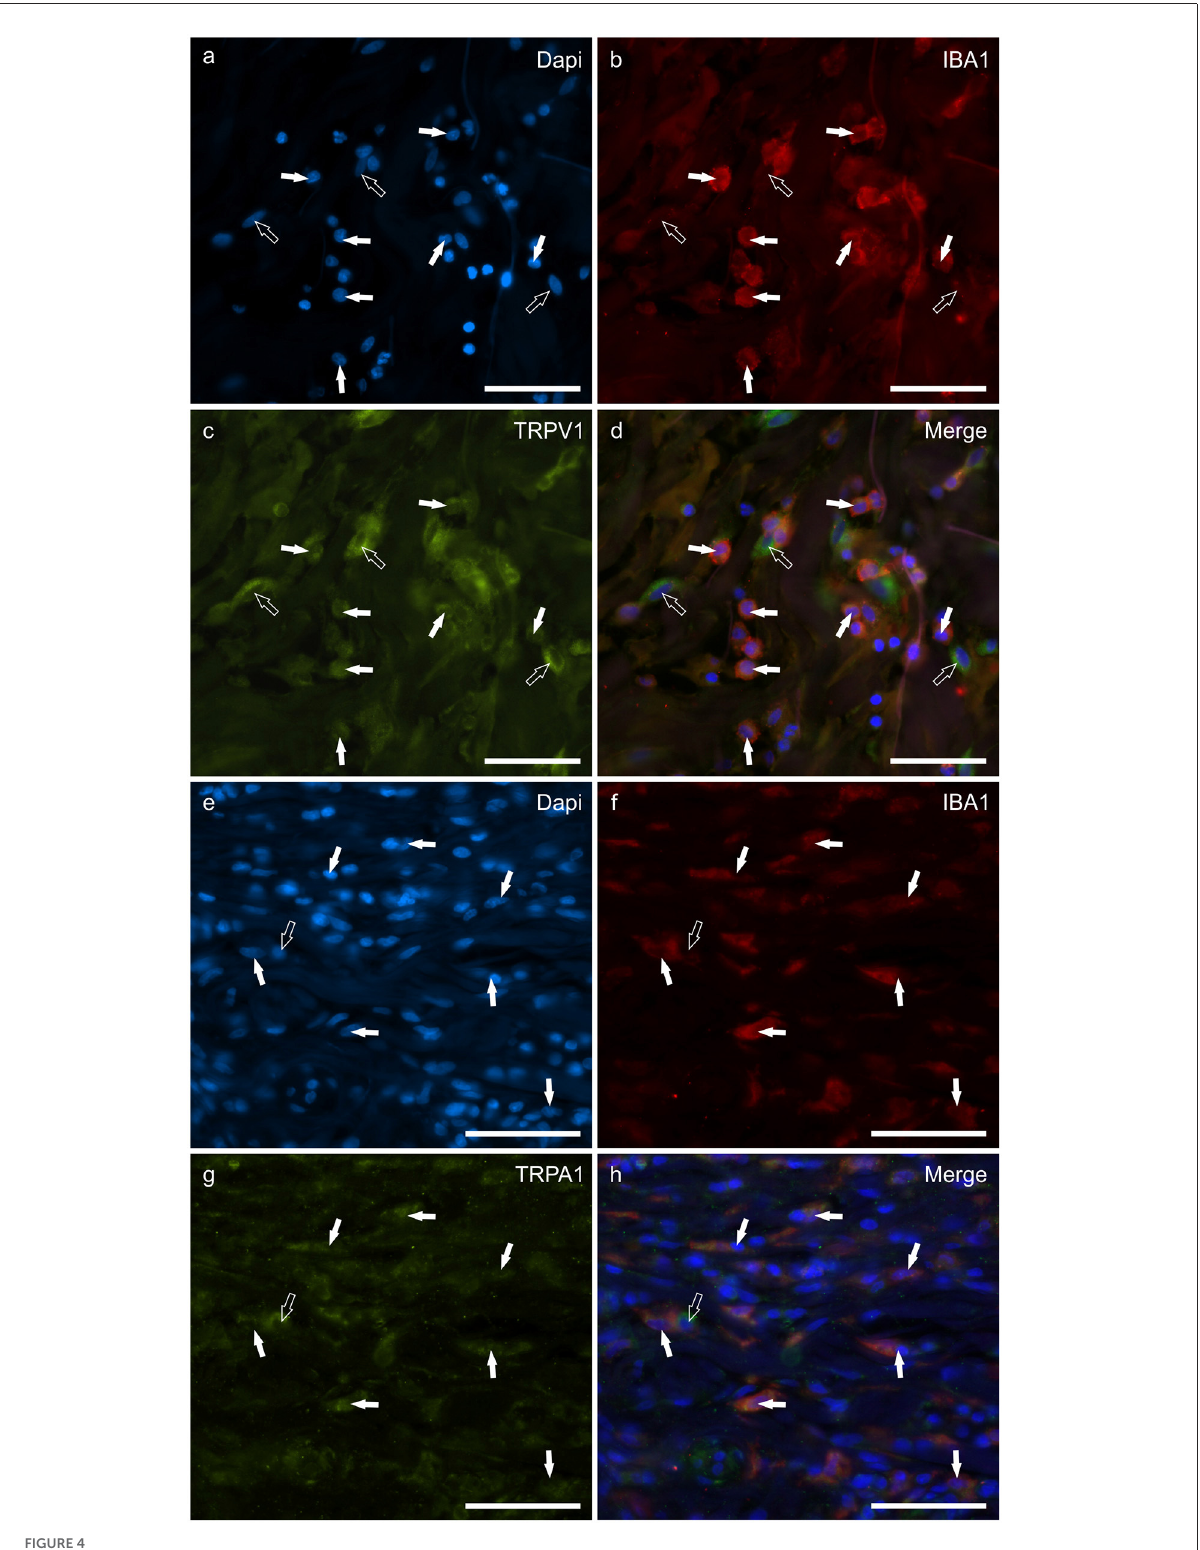
FIGURE4 Photomicrographs of the cryosections of the skin of a dog with atopic dermatitis (AD) showing IBA1 immunoreactive cells (macrophages and dendritic cells) expressing transient receptor potential vanilloid 1 (TRPV1) (a–d) and ankyrin 1 (TRPA1) immunoreactivity (IR) (e–h) . The white arrows indicate the Dapi-labeled nuclei of IBA1 positive cells co-expressing TRPV1-IR (c) and TRPA1-IR (g) . The open arrow indicates one IBA1 negative cell which expressed TRPV1- (c) and TRPA1-IR (g) . Bar: 50 µ